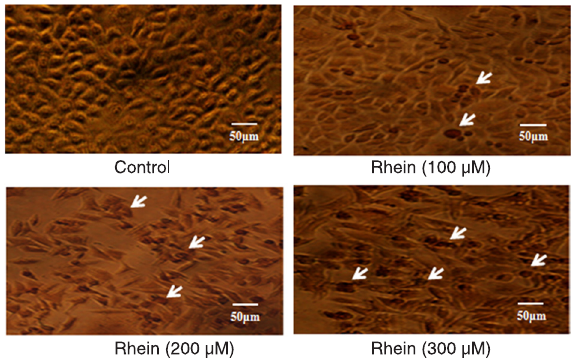
Figure 2. Cell apoptosis observed using TUNEL staining. SGC- 7901 cells were treated with rhein (0, 100, 200, or 300 µM) for 48 h. Apoptotic cells exhibited morphological changes in the nuclei typical of apoptosis. Photographs were taken under an inverted microscope (scale bar, 50 μm). Arrows indicate apoptotic